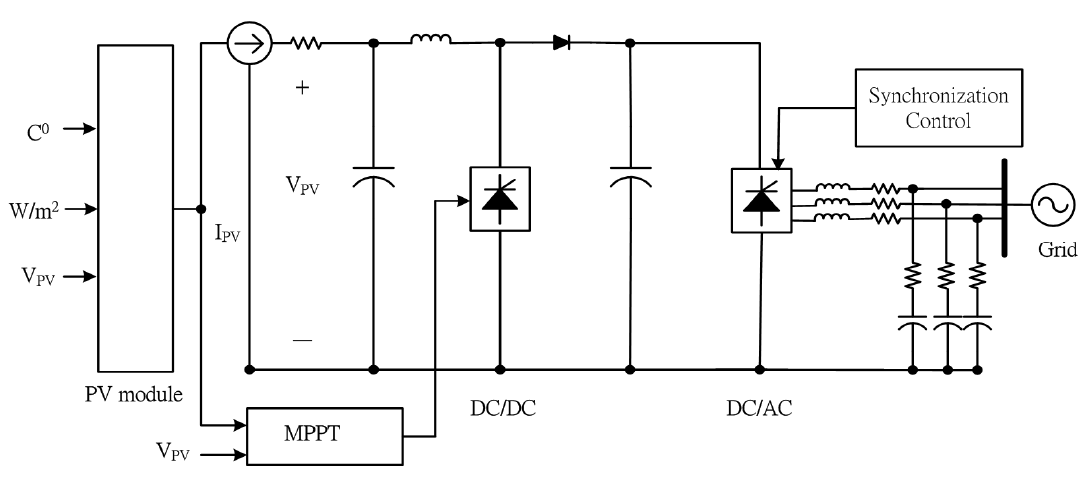
Figure A1. Model of high concentration PV (HCPV) panel and its power converters with maximum power point tracking